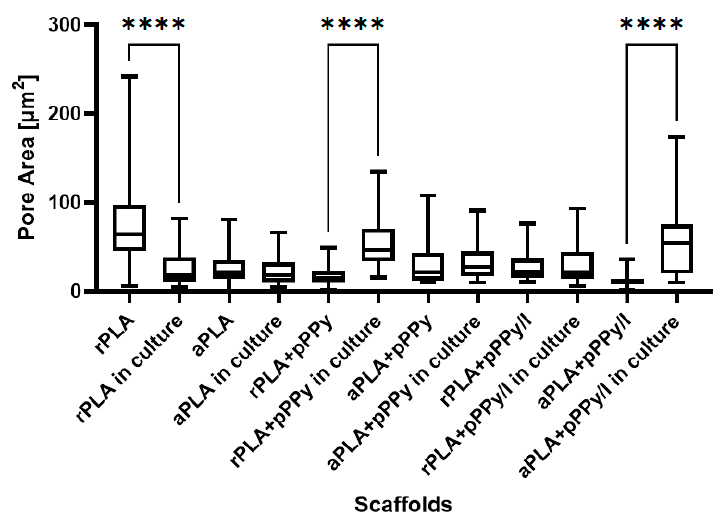
Figure 11. Pore area distributions of scaffolds as-fabricated and in culture, presented as box plots. Statistical differences with the Kruskal–Wallis test and Dunn multiple comparison test, **** p < 0.0001.